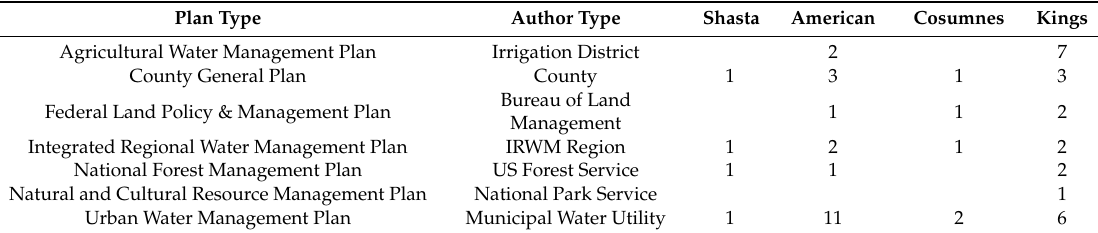
Table 2. Plans included in the